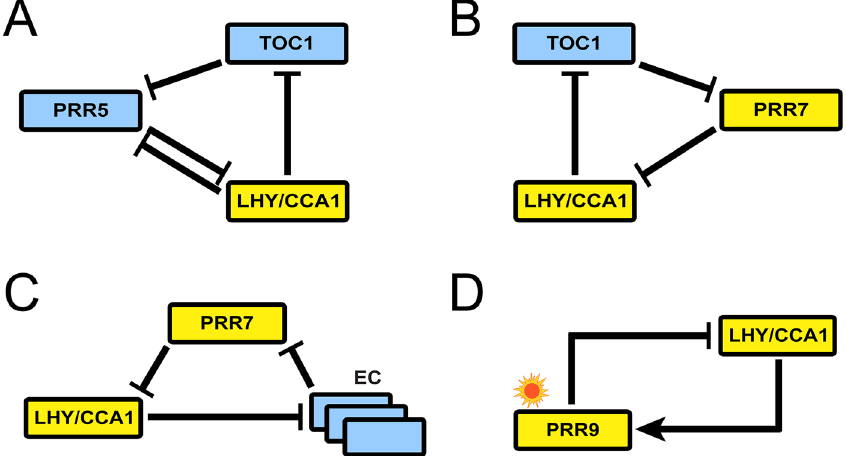
Fig 2. Four major negative feedback loops in the kernel. (A) Loop I. (B) Loop II. (C) Loop III. For visual clarity, the detailed EC subcomponents are omitted (available in Fig 1A). (D) Loop IV. In (A – D), the same symbols were used as in Fig